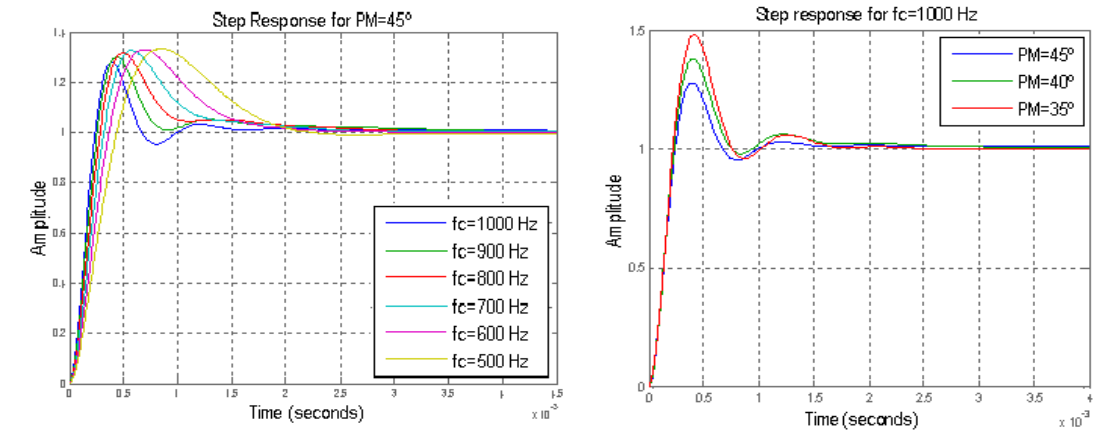
Figure 12. Step Response of the Grid Current Loop for various fc and PM.